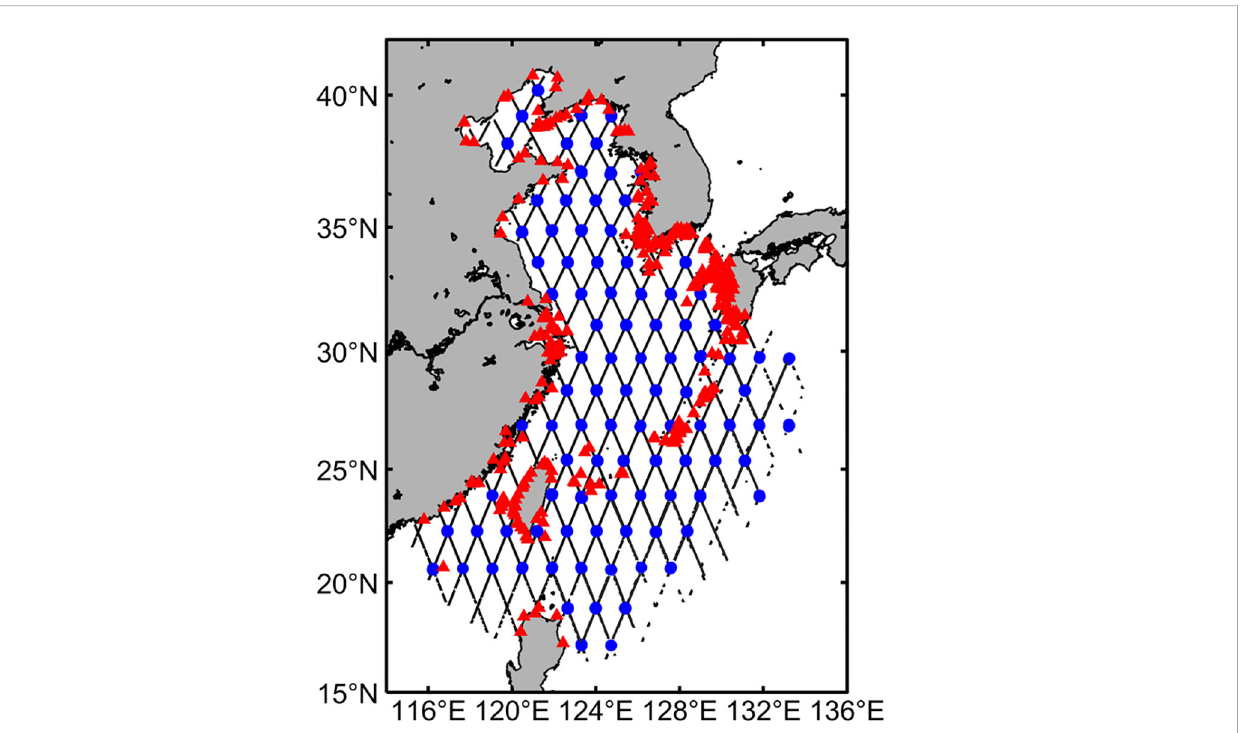
FIGURE 3 Locations of tidal gauge stations (red triangles) and cross points of altimeters (blue dots). The black solid lines show the altimeter